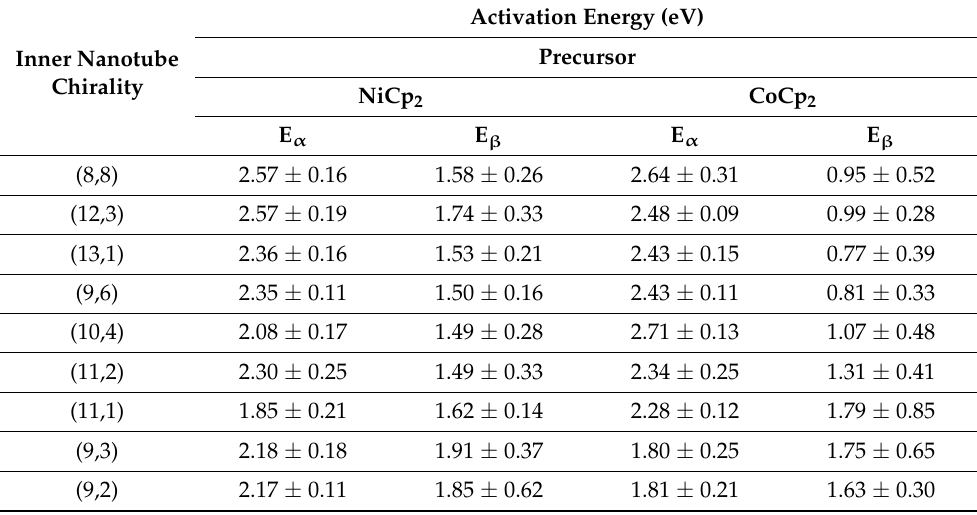
Table 2. The calculated activation energies E α and E β (together with their errors) of the growth of the (8,8), (12,3), (13,1), (9,6), (10,4), (11,2), (11,1), (9,3) and (9,2) inner nanotubes upon the in situ annealing of the NiCp 2 - and CoCp 2 -filled SWCNTs.